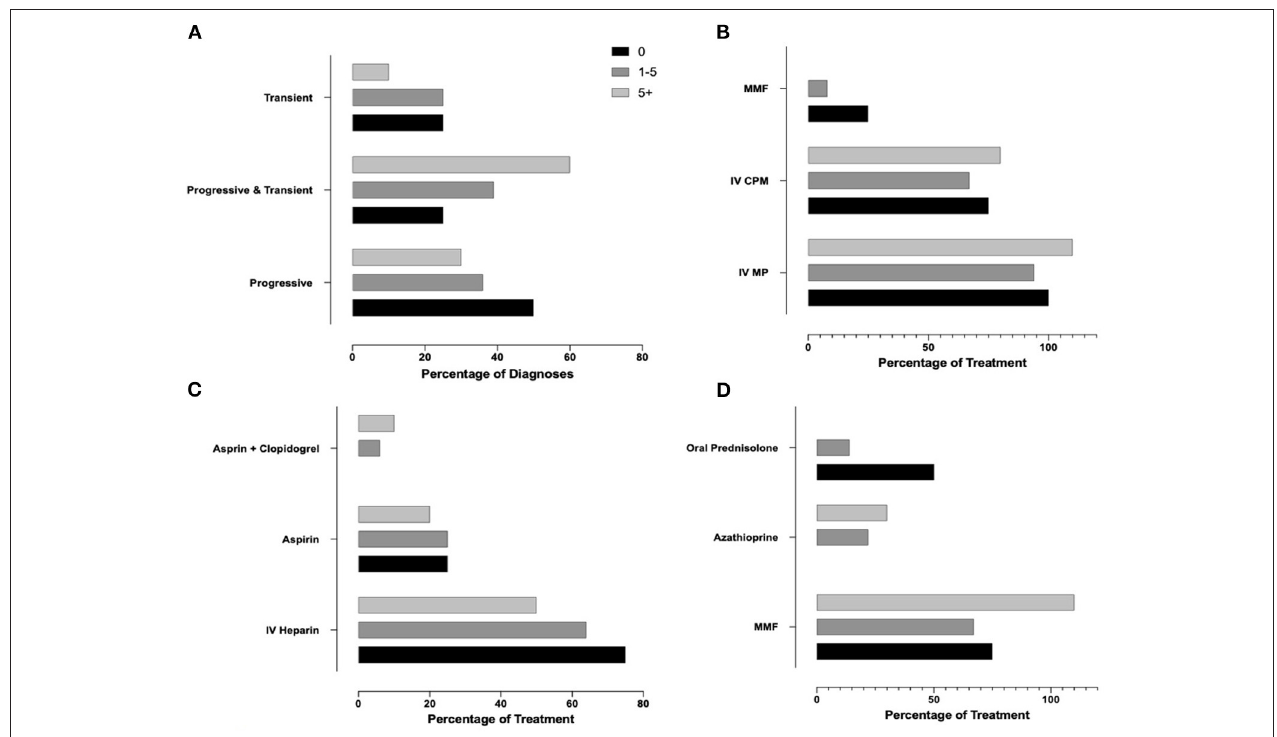
FIGURE 5 | Influence of Experience in Approach to Diagnosis and Treatment in case 1. (A) Correlation between number of patients with p-cPACNS treated and their diagnosis of the patient in case 1. (B) Patients vs. Induction treatment. (C) Patients vs. Acute anticoagulation treatment. (D) Patients vs. Maintenance